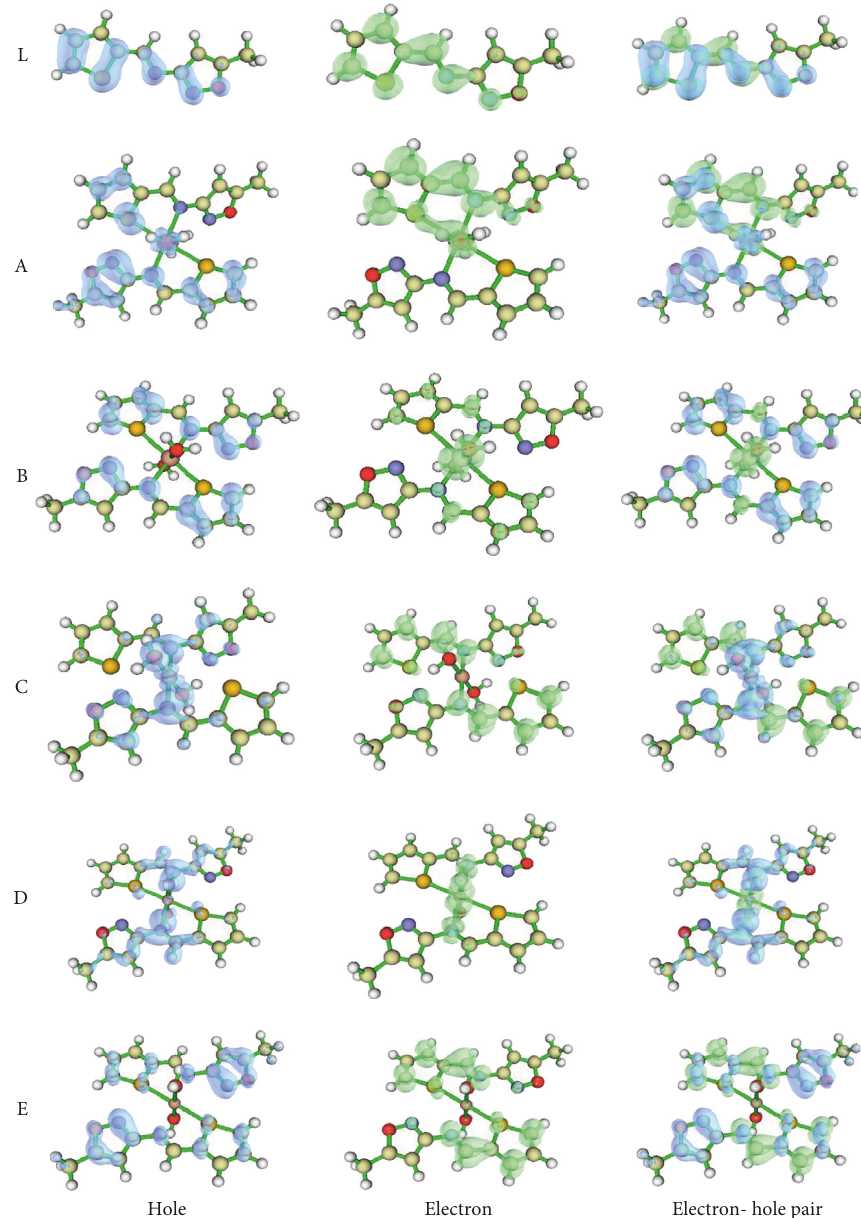
Figure 5: Hole-electron distribution maps of L, B, and C; the blue and green colours represent holes and electrons,